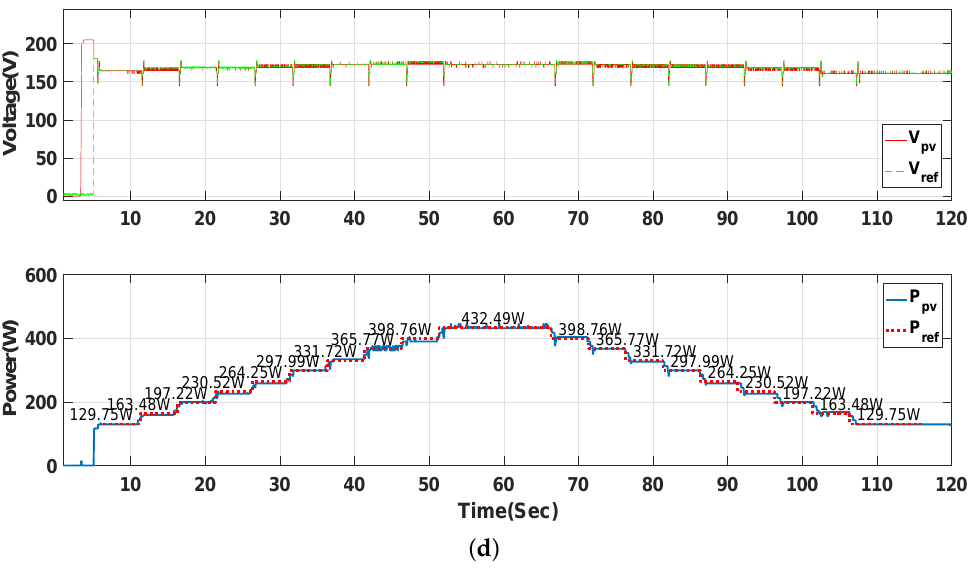
Figure 29. Experimental test of ( a ) P&O; ( b ) INC; ( c ) GSS; ( d ) NQI.